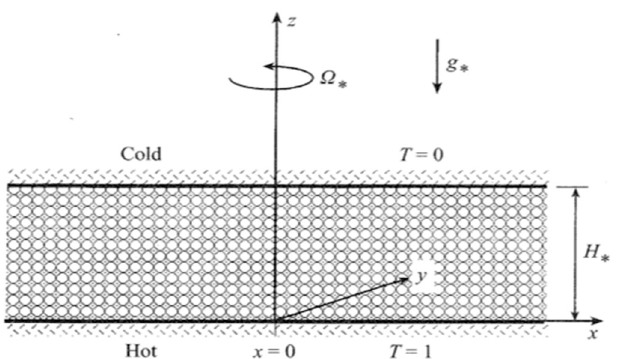
Figure 13. A rotating fluid saturated porous layer heated from below [42]. (Reproduced with permission from Cambridge University Press.)